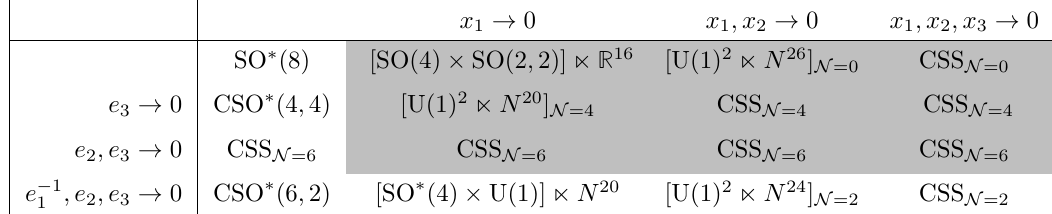
Table 1 . Contractions along the moduli space of the SO (cid:3) (8). The shaded models are those for which we (cid:12)nd uplifts by taking singular limits of a S 3 (cid:2) H 2 ; 2 internal geometry. The full class of CSS gaugings is uplifted to eleven dimensions in section